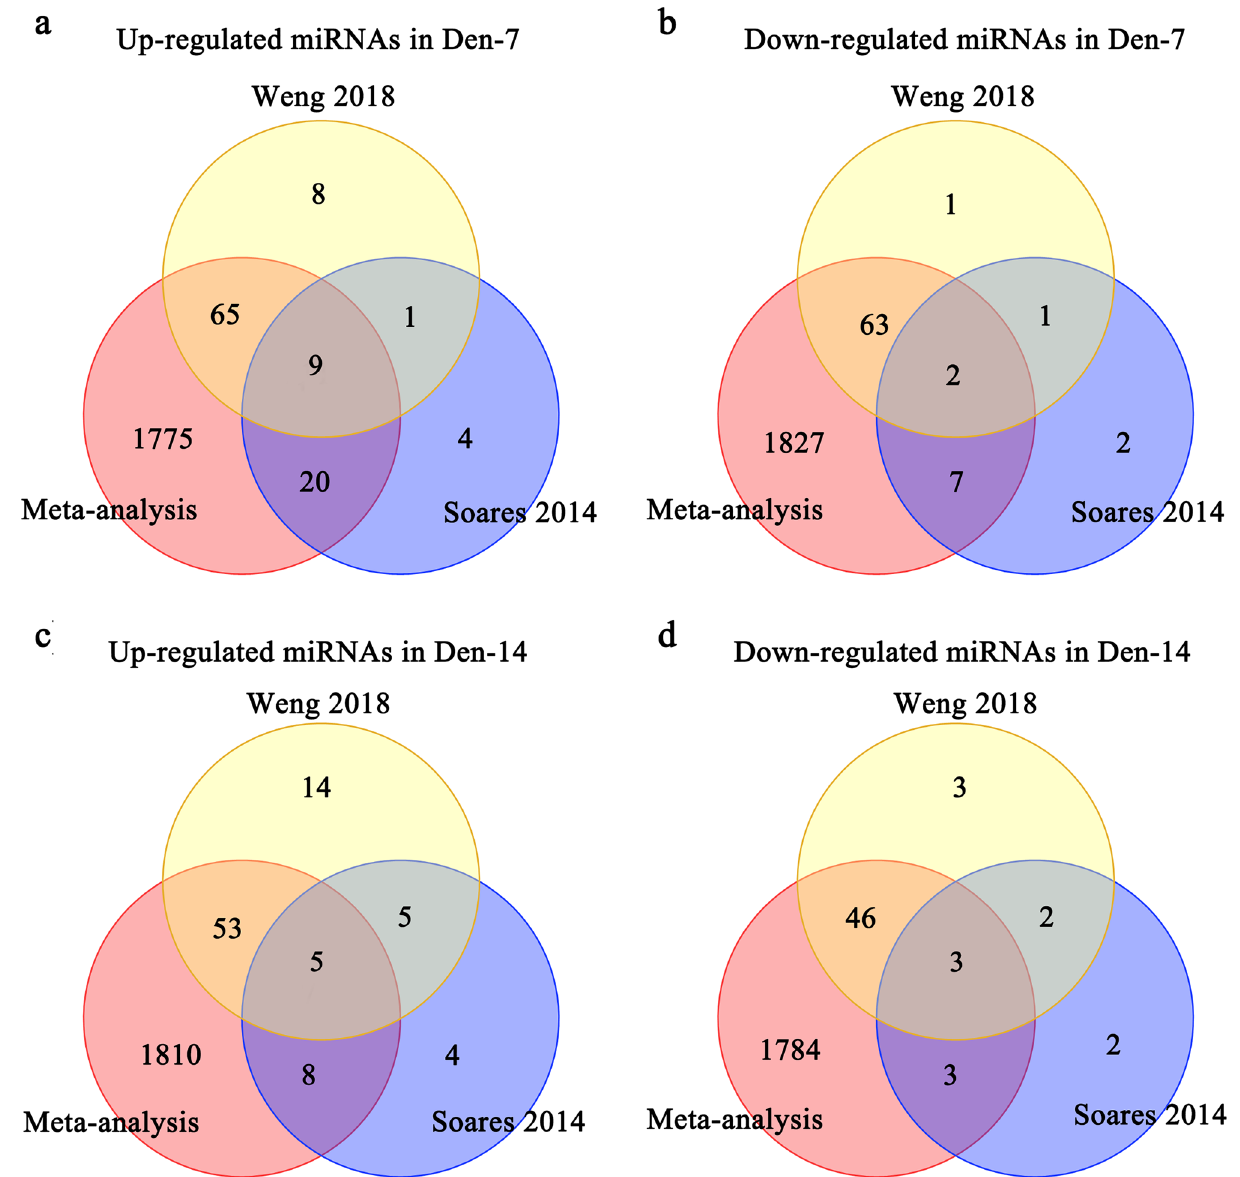
Figure 4. MicroRNAs identified in denervated muscle atrophy. MicroRNAs predicted as targeting mRNAs retrieved by our meta-analysis were further compared with microRNAs identified as differentially expressed in previous studies of denervated muscle atrophy for 7 days and 14 days respectively. ( a ) Venn for up-regulated miRNAs for Den-7 days. ( b ) Venn for down-regulated miRNAs for Den-7 days. ( c ) Venn for up-regulated miRNAs for Den-14 days. ( d ) Venn for down-regulated miRNAs for Den-14 days. Den-7 days denervation for 7 days, Den-14 days denervation for 14